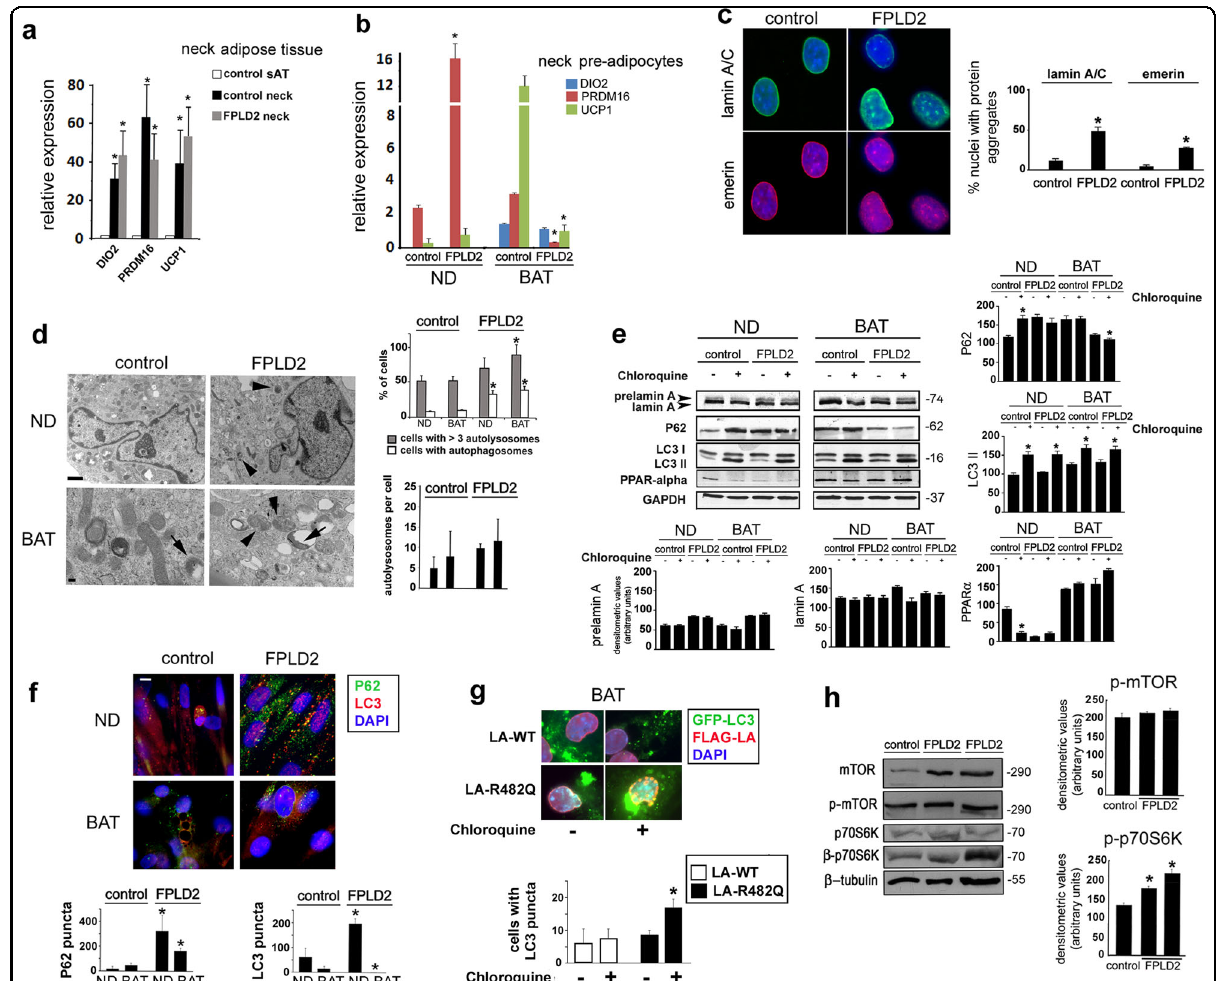
Fig. 1 Early activation of autophagy in laminopathic brown preadipocytes. a Quantitative RT-PCR analysis of the BAT markers DIO2, PRDM16, and UCP1 in subcutaneous adipose tissue of control subjects (control sAT) or in adipose tissue from the neck area of controls (control neck) or FPLD2 patients (FPLD2 neck). Statistically signi fi cant differences are referred to subcutaneous adipose tissue (control sAT) values. b Quantitative RT-PCR analysis of the BAT markers DIO2, PRDM16, and UCP1 in control or FPLD2 neck preadipocytes either non-differentiated (ND) or after 20 days of differentiation toward the brown lineage (BAT). Statistically signi fi cant differences between values measured in control and the corresponding ND or BAT FPLD2 cells are indicated (*). c Control and FPLD2 neck-derived preadipocytes (FPLD2) were costained for lamin A/C (green) and emerin (red), and nuclei were counterstained with DAPI (blue). Bar, 10 μ m. The percentage of nuclei with protein aggregates (lamin A/C or emerin) is reported in the graph. Data refer to 200 nuclei per sample in three independent counts. Statistically signi fi cant differences between values measured in control and FPLD2 ND cells are indicated (*). d Electron microscopy analysis of control (control) or FPLD2 (FPLD2) neck preadipocytes. Pictures from proliferating cells (ND) or after differentiation for 20 days (BAT), displaying mitochondria, autophagosomes (arrowheads), and autolysosomes (arrows). Bar, 1 μ m in the upper panels. Bar, 100nm in the lower panels. The percentage of cells with autophagosomes or with more than three autolysosomes and the number of autolysosomes per cell are reported in the upper graph. The number of autolysosomes per cell is reported in the lower graph. Fifty cells per sample were counted in three independent experiments. Statistically signi fi cant differences between values measured in control and the corresponding ND or BAT FPLD2 cells are indicated (*). e Western blotting analysis of prelamin A and the autophagic markers P62 and LC3 in control and FPLD2 preadipocytes (same samples as in b ). PPARalpha is shown as a marker of differentiation. GAPDH bands are shown as protein loading controls. Molecular weight markers are reported in kDa. Densitometric analysis of immunoblotted prelamin A, lamin A, PPARG alpha, P62, and LC3II bands is reported in the graphs. Statistically signi fi cant differences between values measured in untreated and chloroquine-treated cells are indicated (*). f Immuno fl uorescence analysis of P62 (green) and LC3 (red) in control and FPLD2 preadipocytes (same samples as in b ). DNA was stained with DAPI (blue). Statistical analysis of the number of P62 and LC3 puncta is reported in the graphs. Bar, 10 μ m. Statistically signi fi cant differences between values measured in control and the corresponding ND or BAT FPLD2 cells are indicated (*). g GFP-LC3II and FLAG-LA staining in control BAT adipocytes expressing LA-WT or LA-R482Q. Statistical analysis of the number of cells with GFP-LC3II puncta is reported in the graph. Statistically signi fi cant differences between values measured in LA-WT and the corresponding LA- R482 cells are indicated (*). h Western blotting analysis of mTOR, p-mTOR, p70S6k, and p-p70S6K in control (control) and two different FPLD2 patient ND cell cultures (FPLD2). Tubulin bands are shown as protein-loading controls. Densitometry of phosphorylated proteins is reported in the graph. When comparing wild-type and FPLD2 samples, three biological replicates were used in each experiment as well as in qRT-PCR analyses. Statistically signi fi cant differences between values measured in control and FPLD2 cells are indicated